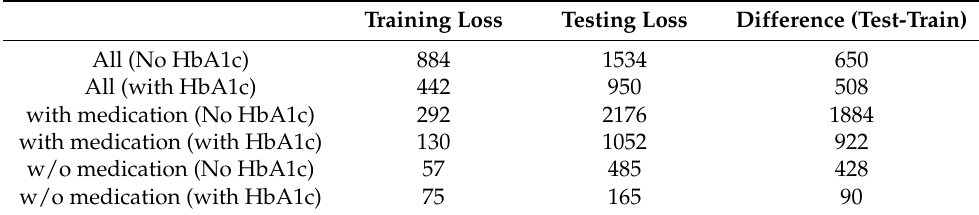
Figure 4. Performance comparison of cohorts without medication (856 samples), with medication (1682 samples), and with medication and downsized samples (randomly selected 856 samples, 10 replications) in ratio of zone A of CEG plot. Both results of with HbA1c and without HbA1c are presented. Table 4. The average training and testing loss (Equation (1)) of each